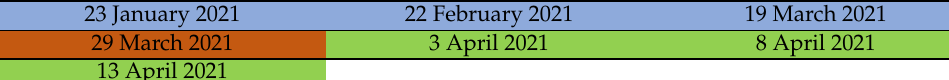
Table 2. The list of Sentinel-2 imagery spanning the time before (blue), during (red), and after (green) the Suez Canal blockage.